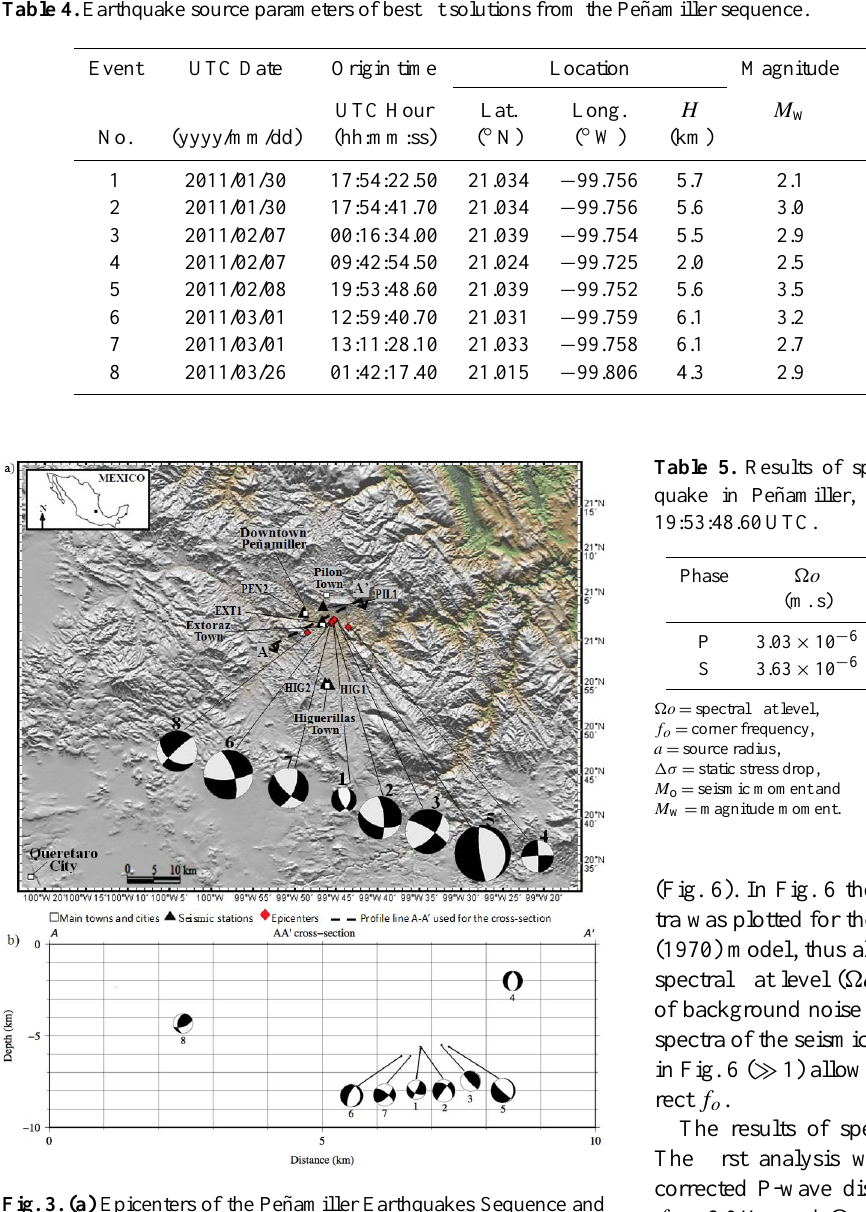
Fig. 3. (a) Epicenters of the Peñamiller Earthquakes Sequence and fault plane solutions (focal mechanisms) for eight events employed in the inversion procedure. (b) Cross-section A − A 0 with hypocen- ters.